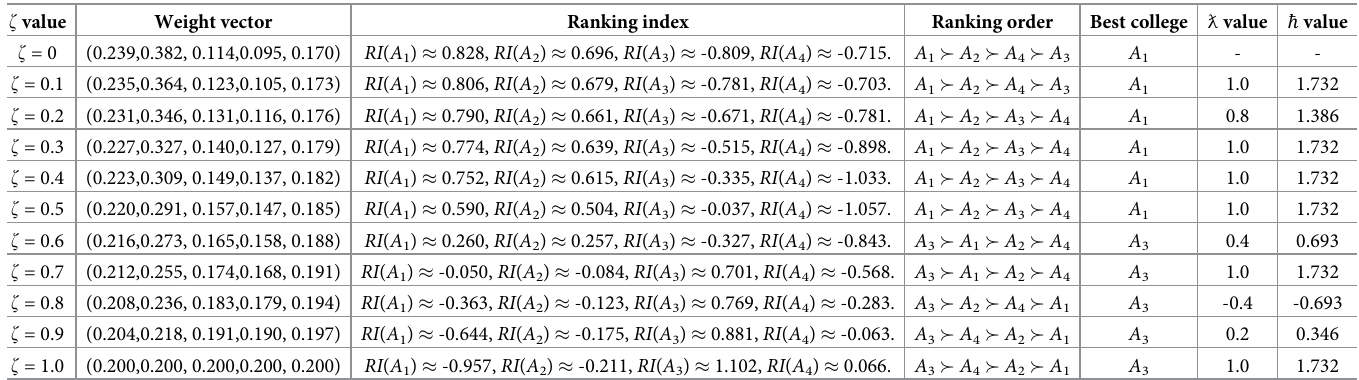
Table 9. Ranking orders with different z values.